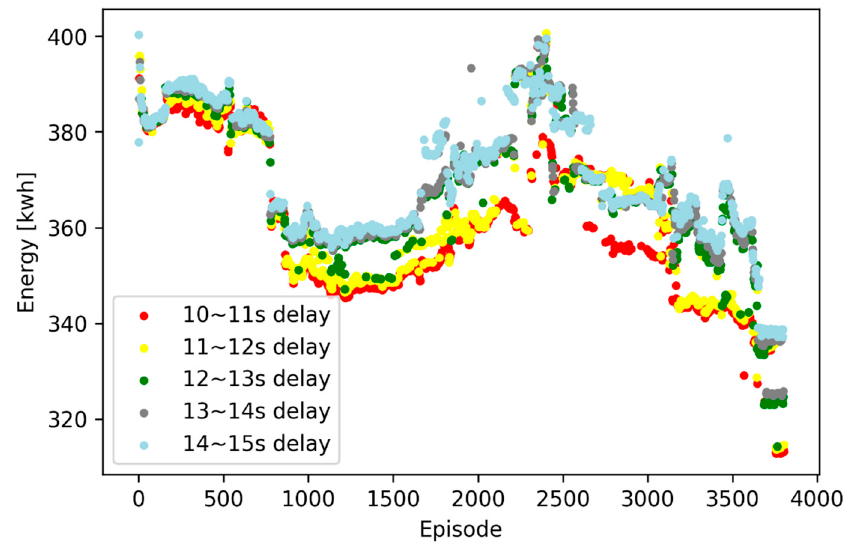
Figure 10. Energy consumption during the training process under continuously sampling random disturbances in the two-train network.